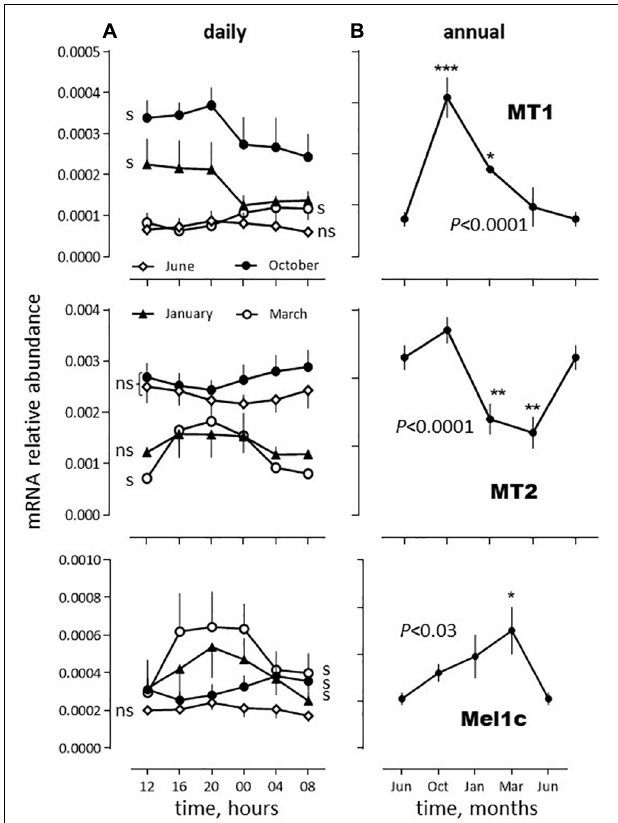
FIGURE 4 | Relative daily (A) and annual (B) variations in mRNA abundance of sea bass melatonin receptors mRNA in vivo . The data were obtained